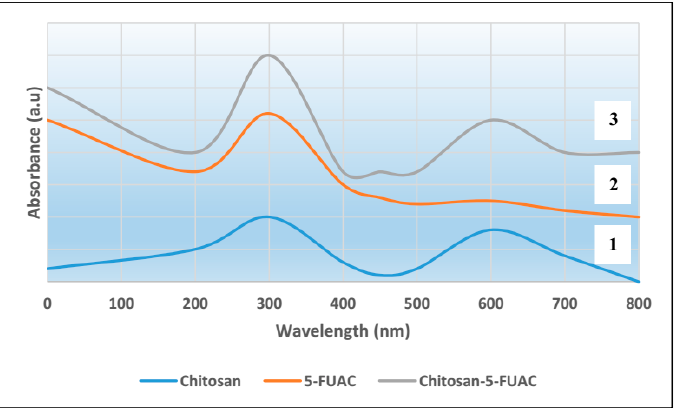
Figure 4. FT-IR spectra of CS-FUAC conjugate.